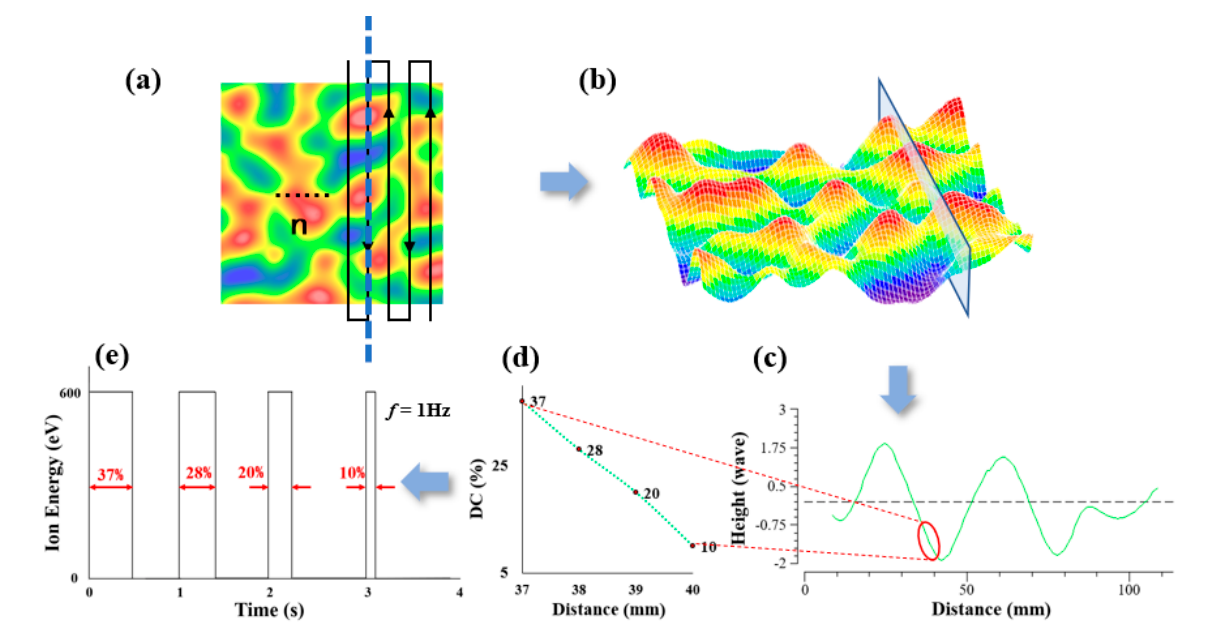
Figure 1. ( a ) Processing removal amount. ( b ) The section corresponding to the dotted line. ( c ) Section surface shape at dotted line. ( d ) Duty cycle corresponding to the surface in circle. ( e ) Duty cycle to voltage.